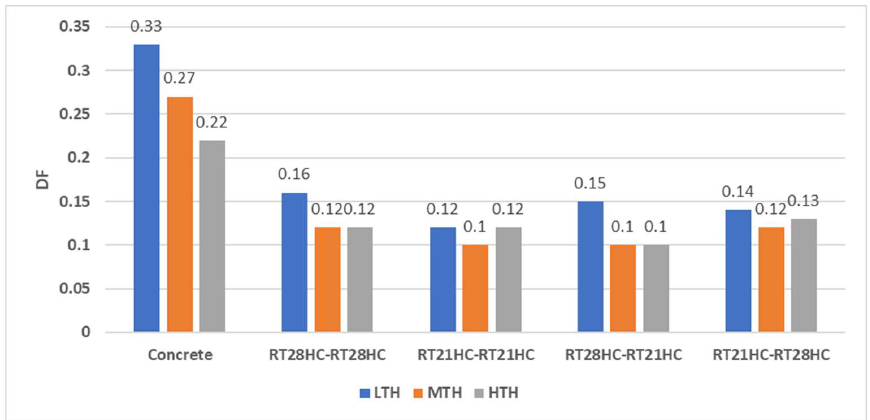
Figure 14. DF values for concrete-only samples and samples with integrated PCMs.